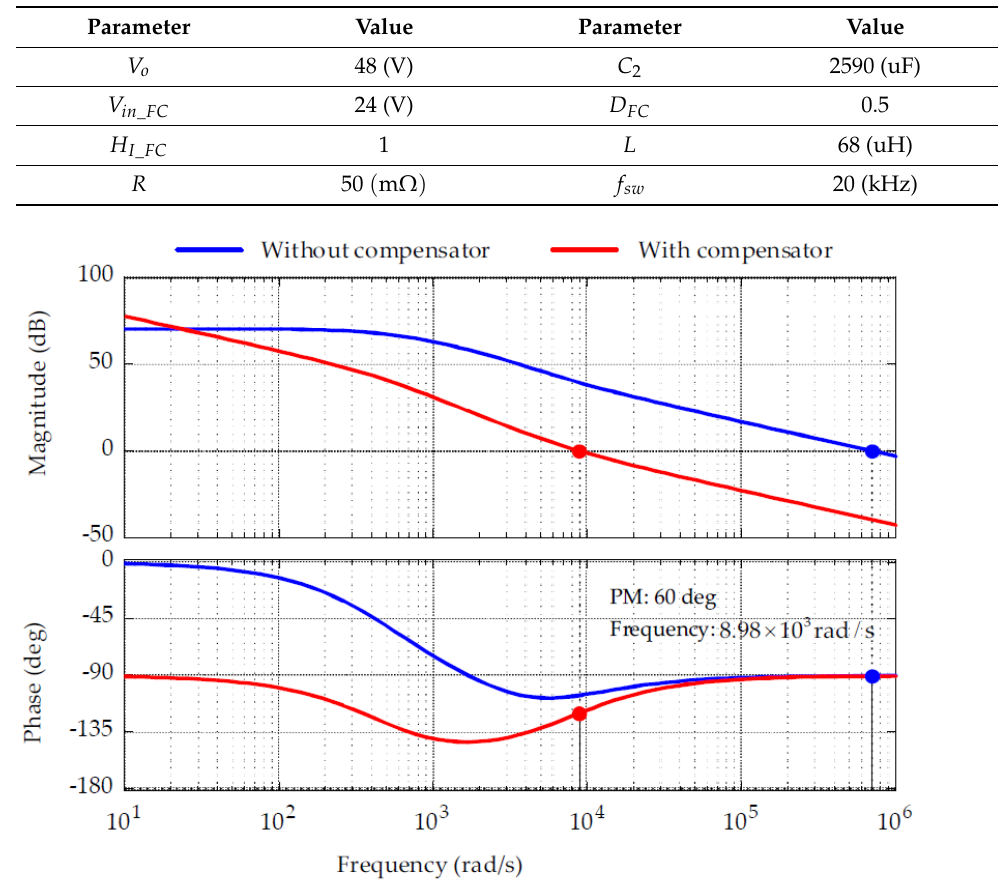
Figure 16. Bode diagram of the PEMFC current control loop. Table 7. Parameters of the PEMFC converter.